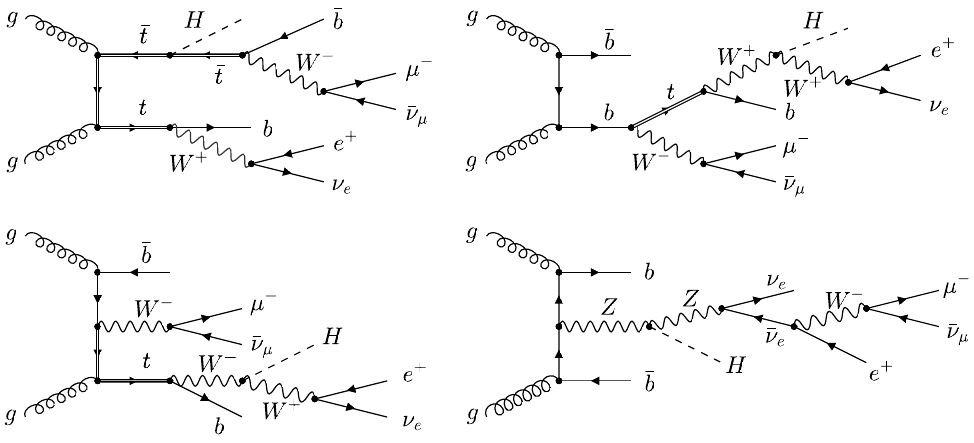
Figure 1 . Representative Feynman diagrams of the double, single and non-resonant top-quark contributions that are part of the matrix element employed in the full off-shell computation for the pp → e + ν e µ − ¯ ν µ b ¯ b H process. Feynman diagrams were produced with the help of the FeynGame program